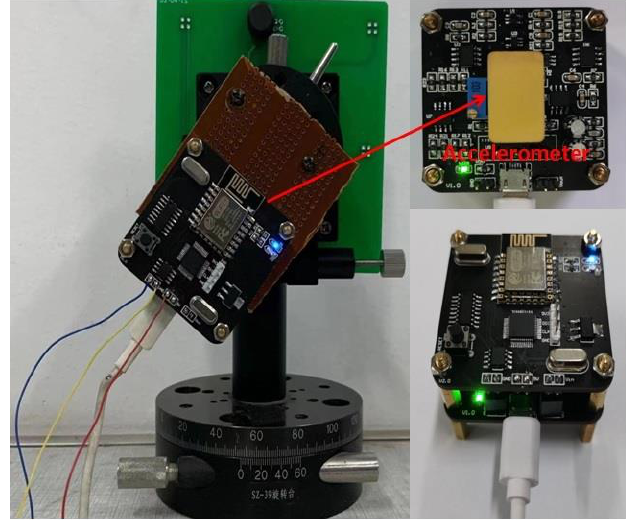
Figure 19. Experimental circuit. The encoder was adjusted to achieve an angle difference of 15 ◦ of rotation and decom- pose the acceleration into the corresponding sine components. When the detection voltage changed to 1 V and the corresponding acceleration rotation angle was from − 90 ◦ to 90 ◦ , the relationship between acceleration and resonant frequency was as shown in Figure 20, and the sensitivity was 44.5 Hz/g. When the detection voltage was 3 V, the relationship between acceleration and resonant frequency was as shown in Figure 21. A large detection voltage corresponds to a high sensitivity, but the resonant frequency and accel- eration have a severely nonlinear relationship.